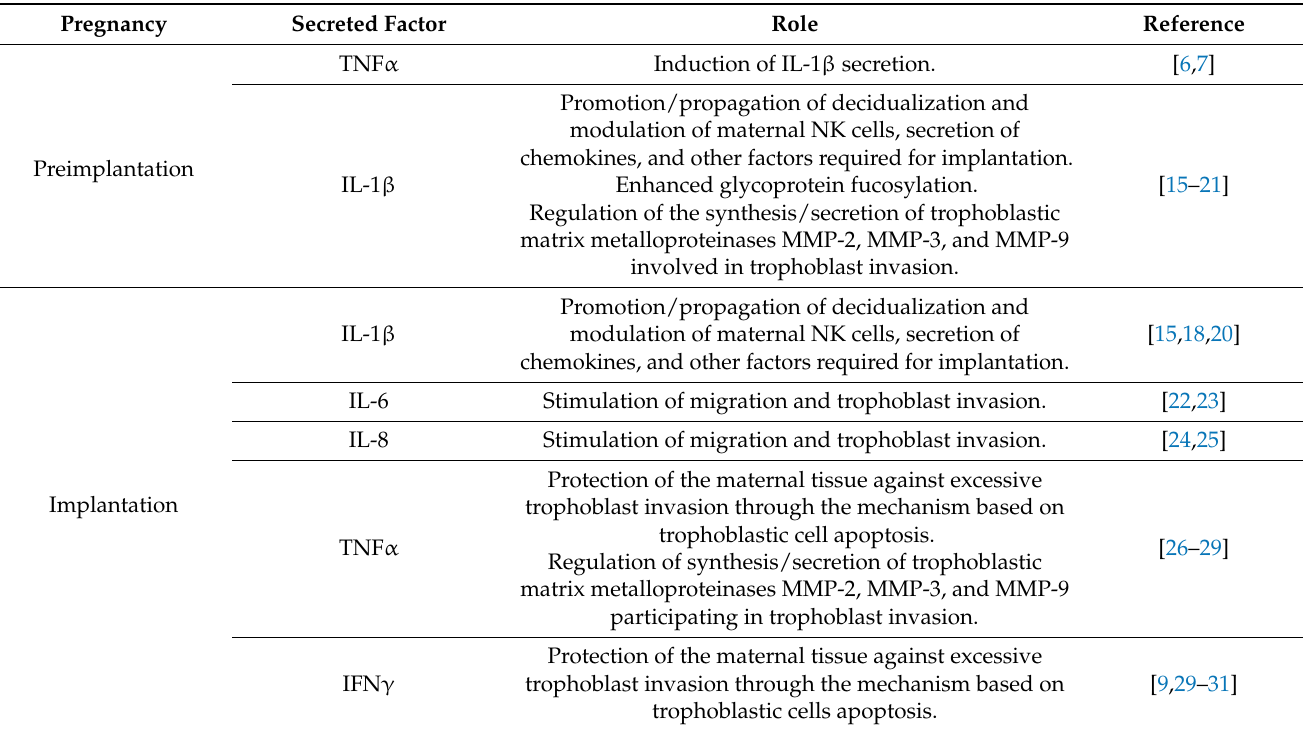
Table 1. Secreted cytokines that mediate inflammation and their role in the implantation process. Pregnancy Secreted